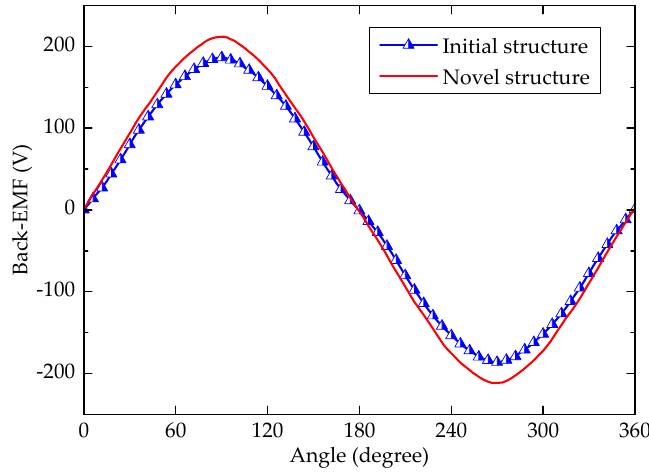
Figure 6. Cogging torque waveforms of the two FSPM machines.